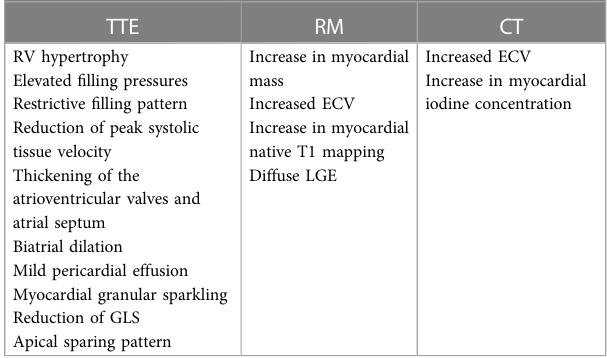
TABLE 1 Imaging RED FLAGS for suspicion of ATTRwt-CA in severe AS patients. Imaging RED FLAGS for suspicion of ATTRwt-CA in severe AS TTE RM